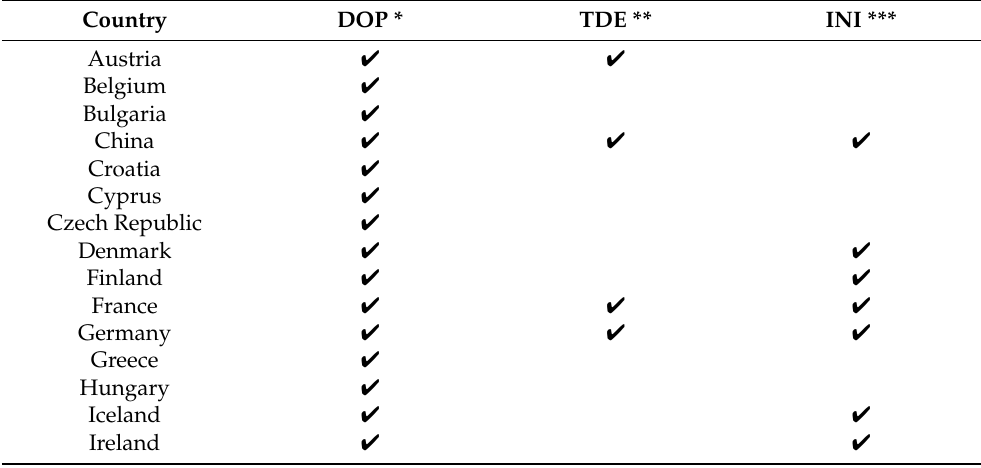
Table 5. Policies adopted by countries to promote EV powered by RES (2020). Country